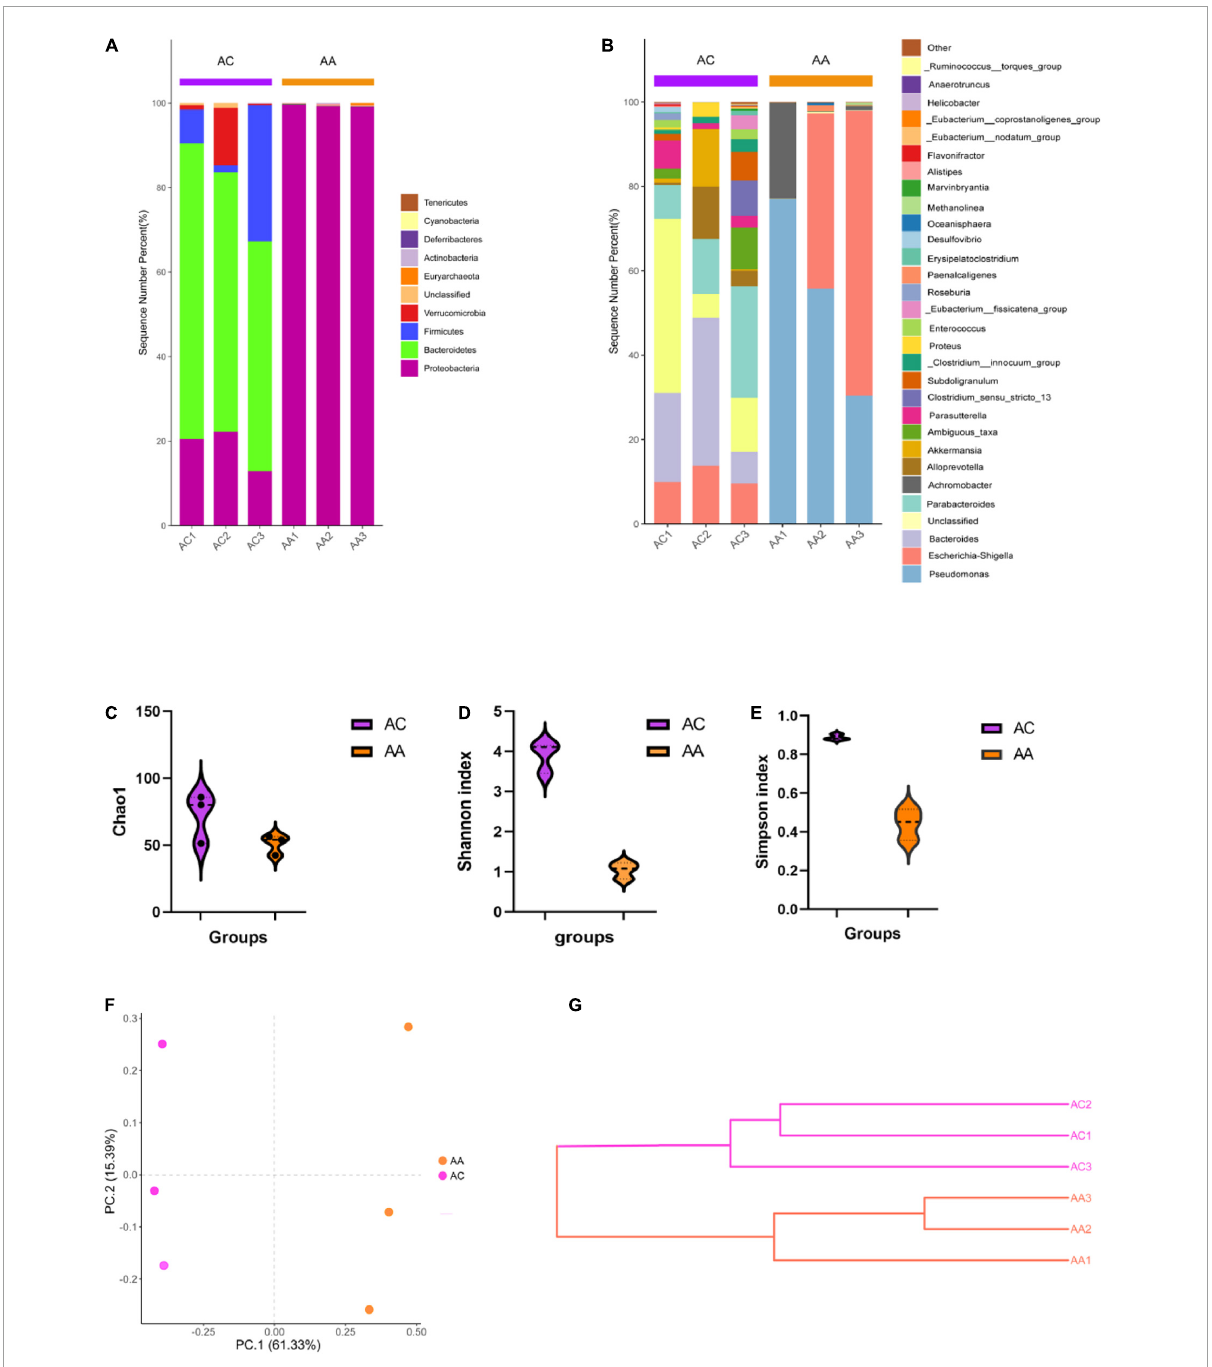
FIGURE1 Antibiotic cocktail treatment effects on gut microbial diversity. (A) Phylum level gut microbial structure; (B) Genus level gut microbial composition; (C–E) Alpha diversity analysis; (F,G) beta diversity analysis.